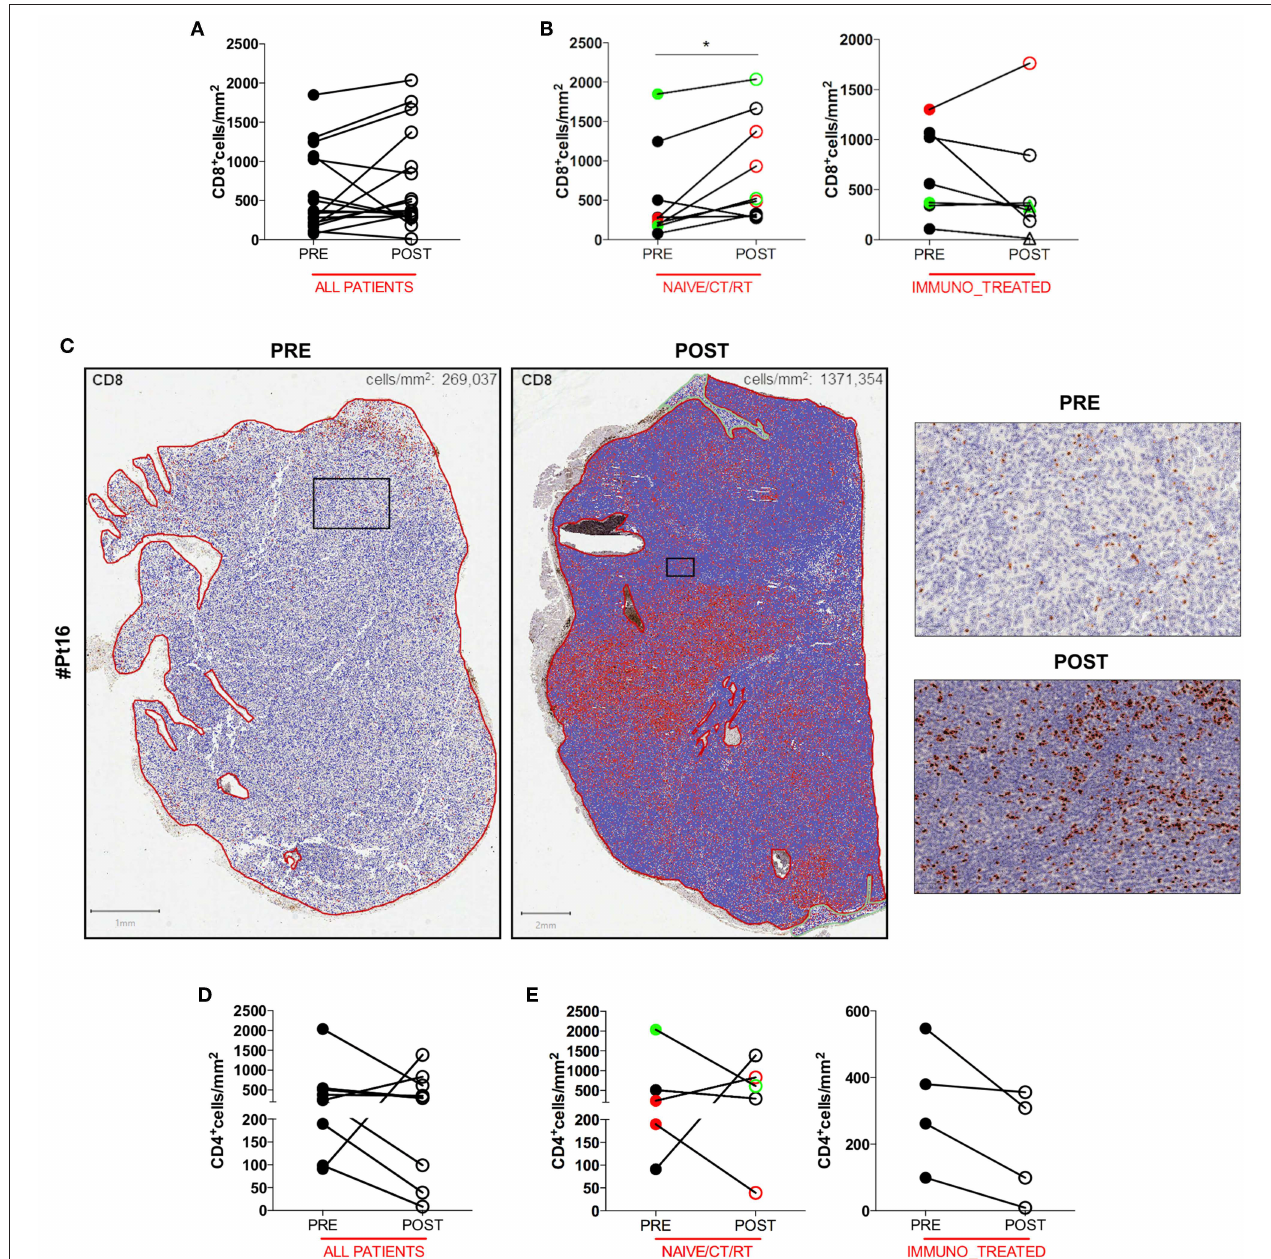
FIGURE 1 | Quantitative analysis of intratumoral CD8 + and CD4 + T cells of serial tumor biopsies from DC vaccine treated patients. The number of intratumoral CD8 + T cells per mm 2 in matched pre- and post- treatment samples is plotted in graphs. Graph showing all patients ( n = 16, p = 0.2144) (A) . Right and left graphs showing naïve/CT/RT ( n = 9, * p = 0.0195), and immuno_treated ( n = 7, p = 0.2969), respectively (B) . Whole slide images (WSI) of CD8 staining in the pre- and post-vaccine lesions of one representative patient (Pt#16). Scale bars 1 and 2mm for the left and the right WSI panel, respectively. Higher magnification images for the mark-up CD8 stain in pre- and post- treatment samples are shown. Scale bars, 100 µ m (C) . The number of intratumoral CD4 + T cells per mm 2 in matched pre- and post- treatment samples is plotted in graphs. Graph showing all patients ( n = 9, p = 0.4258) (D) . Right and Left graphs showing naïve/CT/RT ( n = 5, p > 0.9999) and immune_treated ( n = 4, p = 0.1250), respectively (E) . CR and PR Patients are displayed in green, SD in black, and PD in red. Open circles denote on-treatment samples, open triangles post-treatment ones. Statistical comparisons are based on the non-parametric two-tailed Wilcoxon signed-rank test. Only values statistically significant are reported: * p <